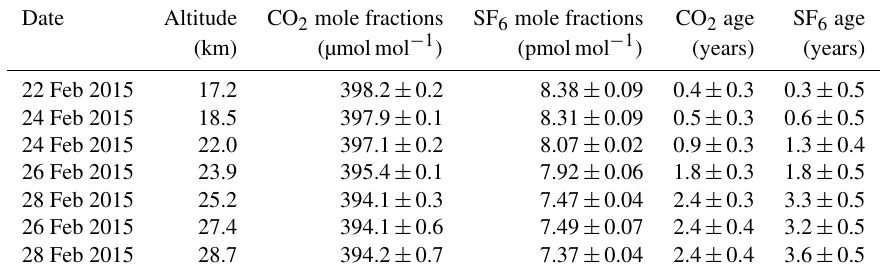
Table 1. CO 2 and SF 6 mole fractions and ages observed over Biak, Indonesia in February 2015.